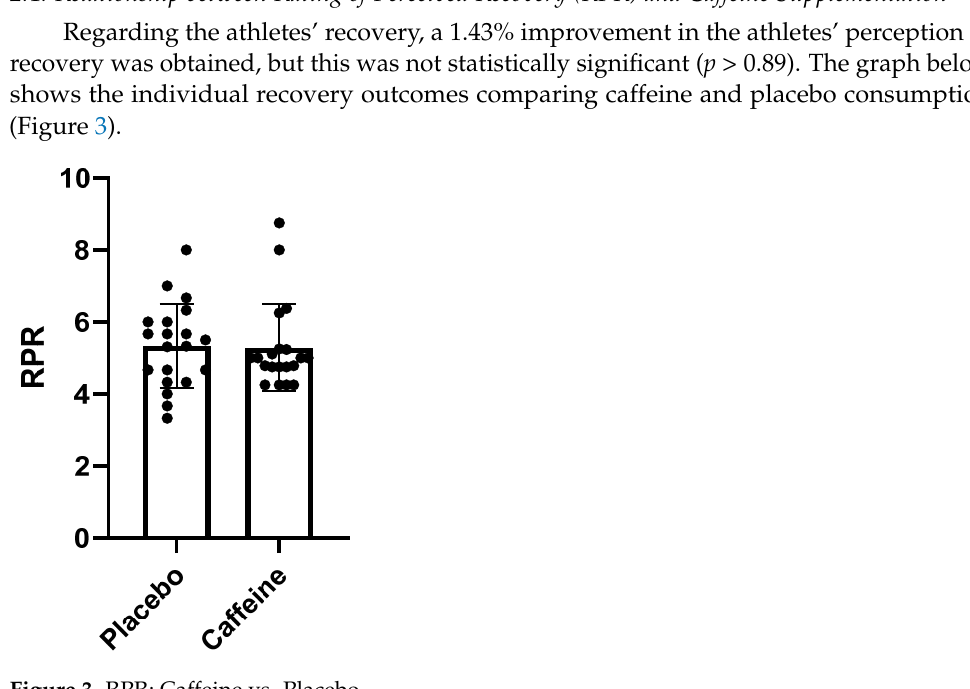
Figure 2. RPE: Caffeine vs Placebo.